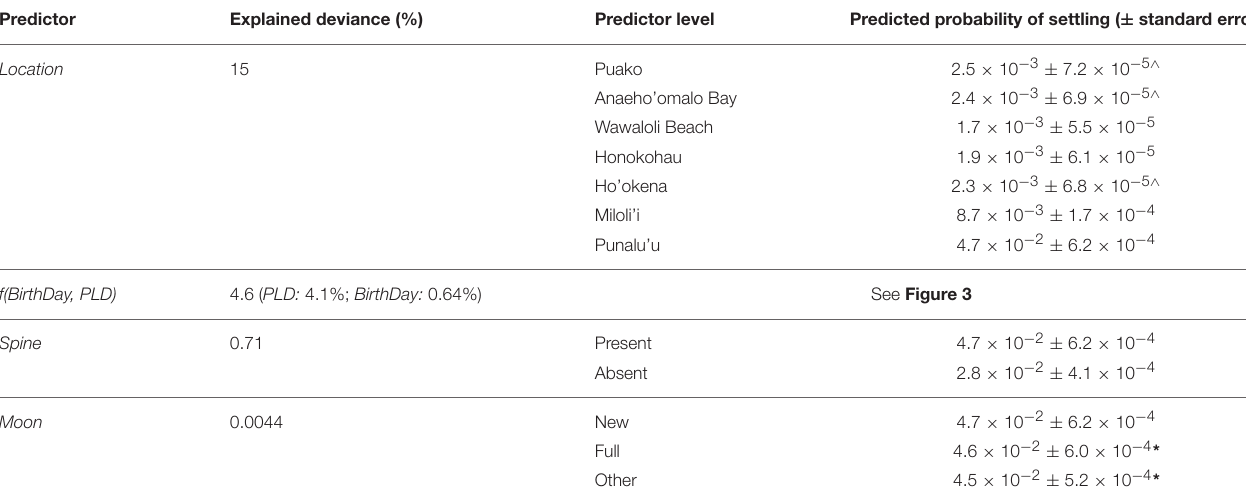
TABLE 1 | Results of the best-specified model (Equation 13) including % explained deviance by each predictor as well as probability of settling estimates. Predictor Explained deviance (%) Predictor level Predicted probability of settling ( ± standard error)